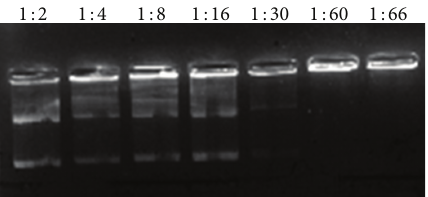
Figure 3: Agarose gel. DNA release from chitosan-plasmid com- plexes at different ratios.